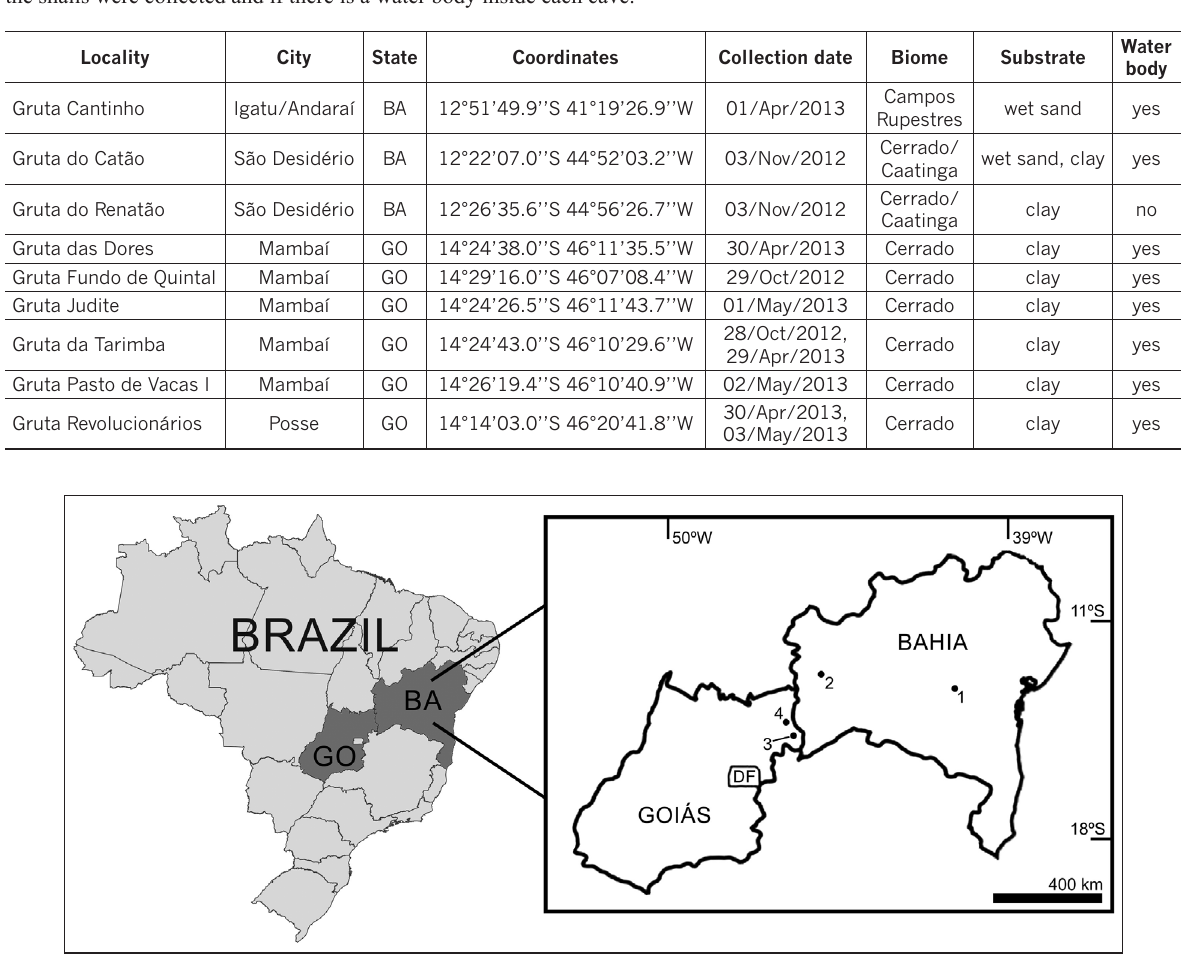
Type material. Holotype: MZSP 122725 (Figs 2–4). Paratype: MZSP 122726, from type locality (Figs 5–6).